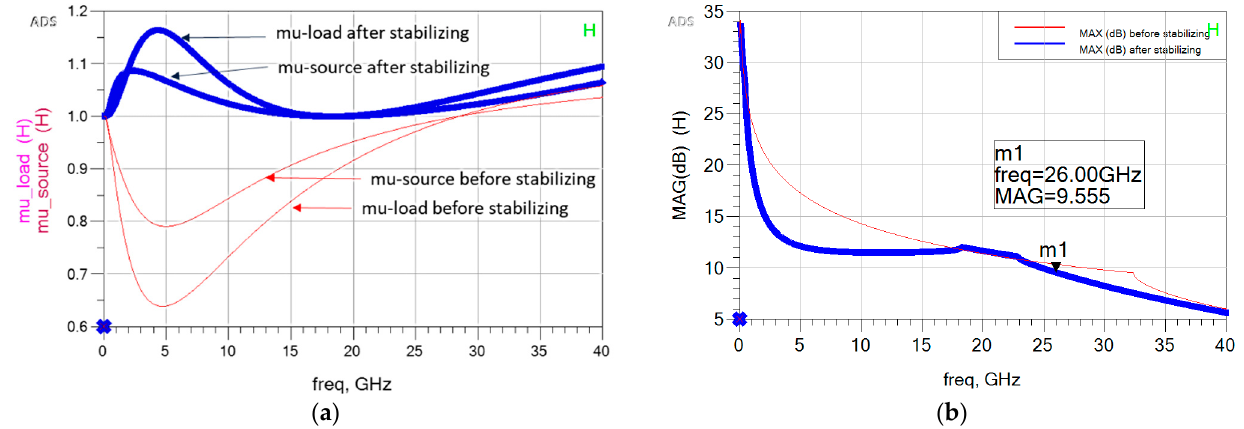
Figure 2. ( a ) Driver transistor cell stability and ( b ) MAG before and after stabilizing.